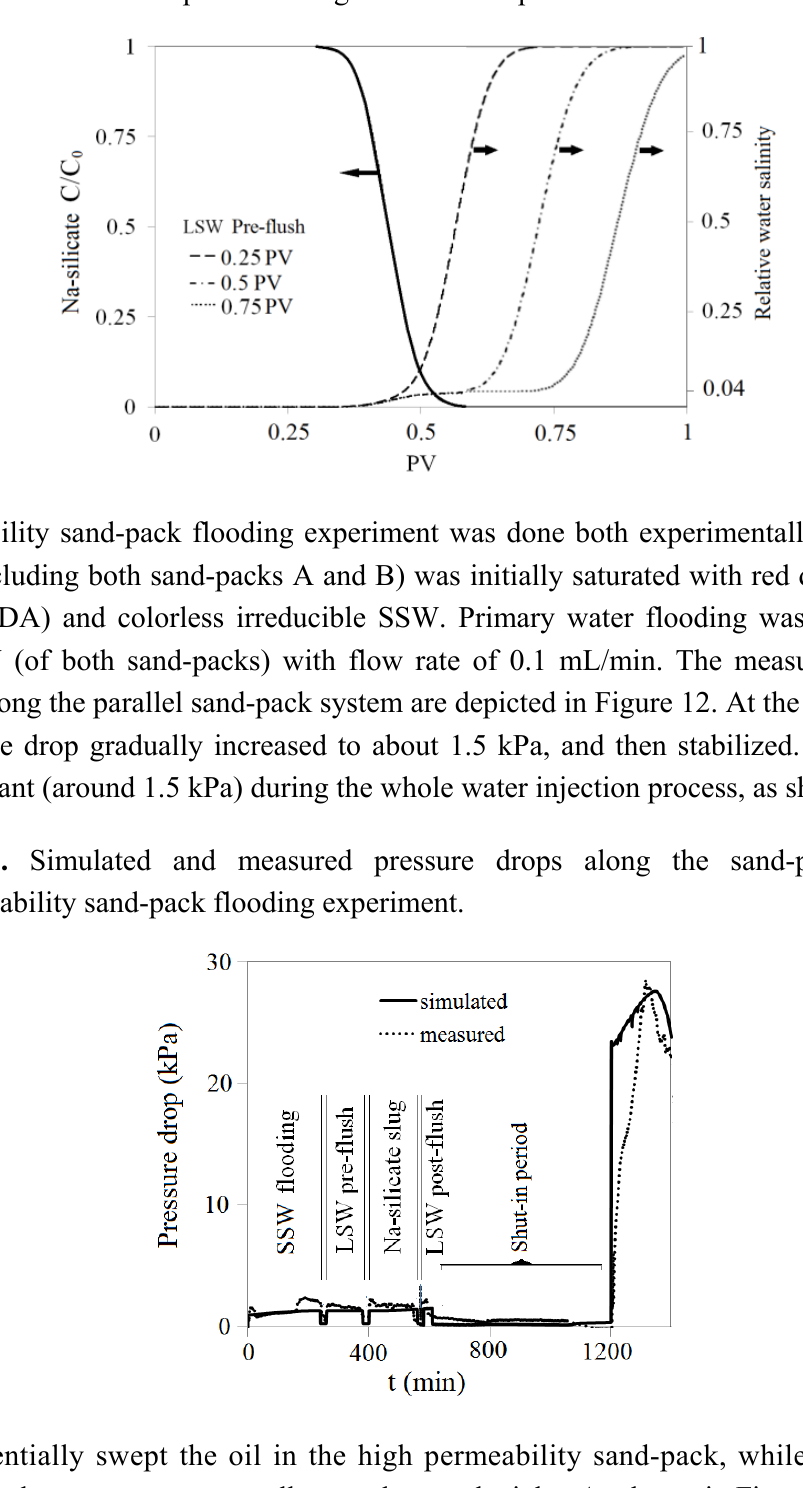
Figure 11. Simulated profiles of Na-silicate relative concentration and relative water salinity for different LSW pre-flush slug sizes in sand-pack A.